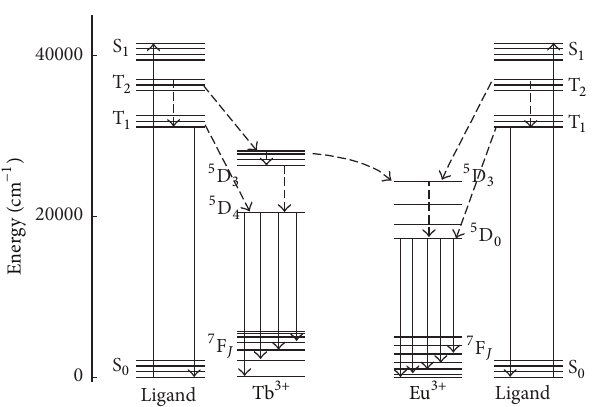
Figure 10: Schematic diagram of luminescence mechanism in TBA/EBA incorporated